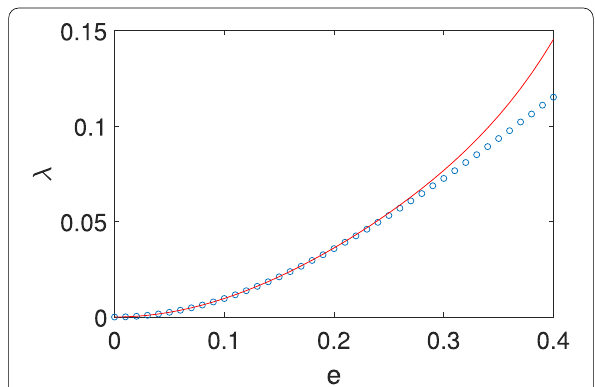
Fig. 5 (Color online) A comparison of the analytic approximation with the numerical simulation for Eq. (57). The Monte carlo results are marked with (blue) circles while the analytic approximation is plotted with (red) solid